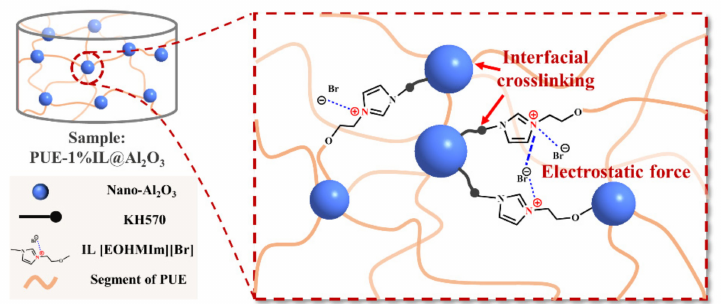
Figure 8. An inner structure diagram of the specimen of composite material (PUE-1%IL@Al 2 O 3